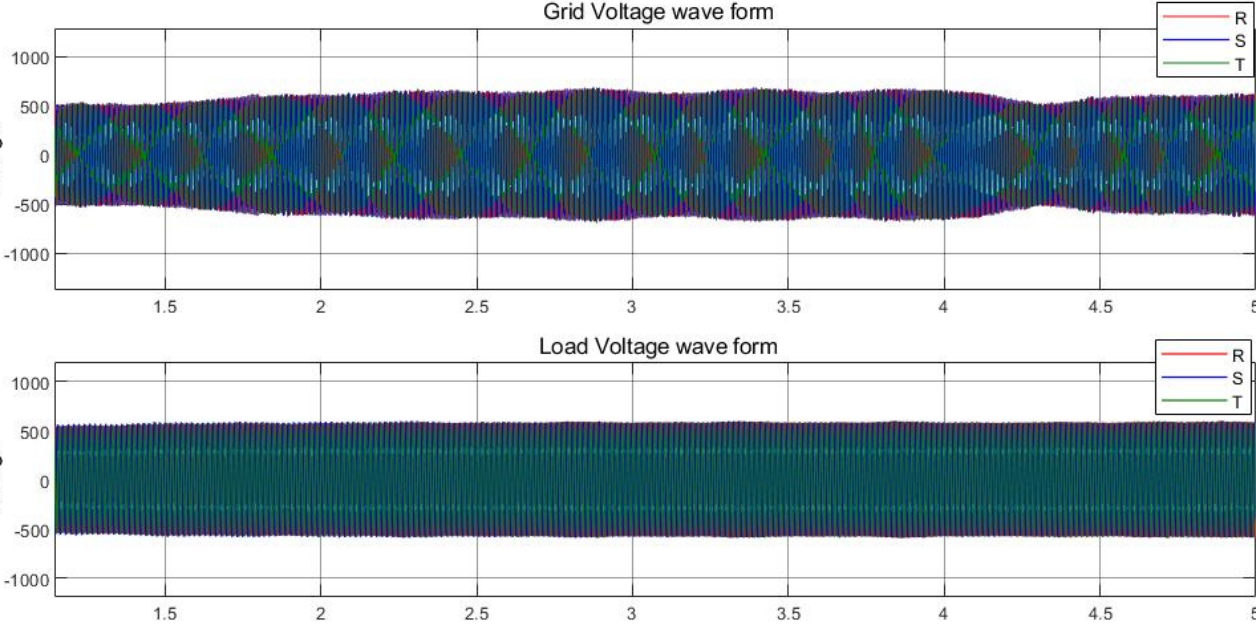
Figure 17. Load-side voltage and grid-side voltage amplitude with non-linear load on the grid side using PWM.